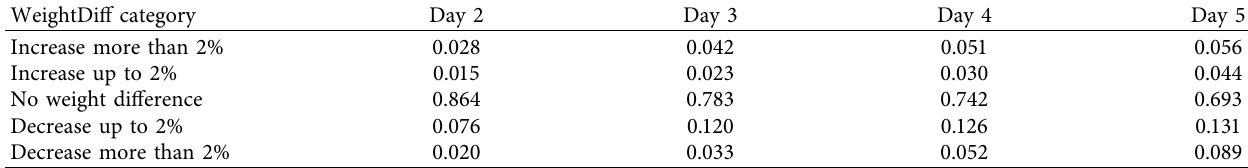
Table 4: Empirical probability of weight increase or decrease for pediatric patients.